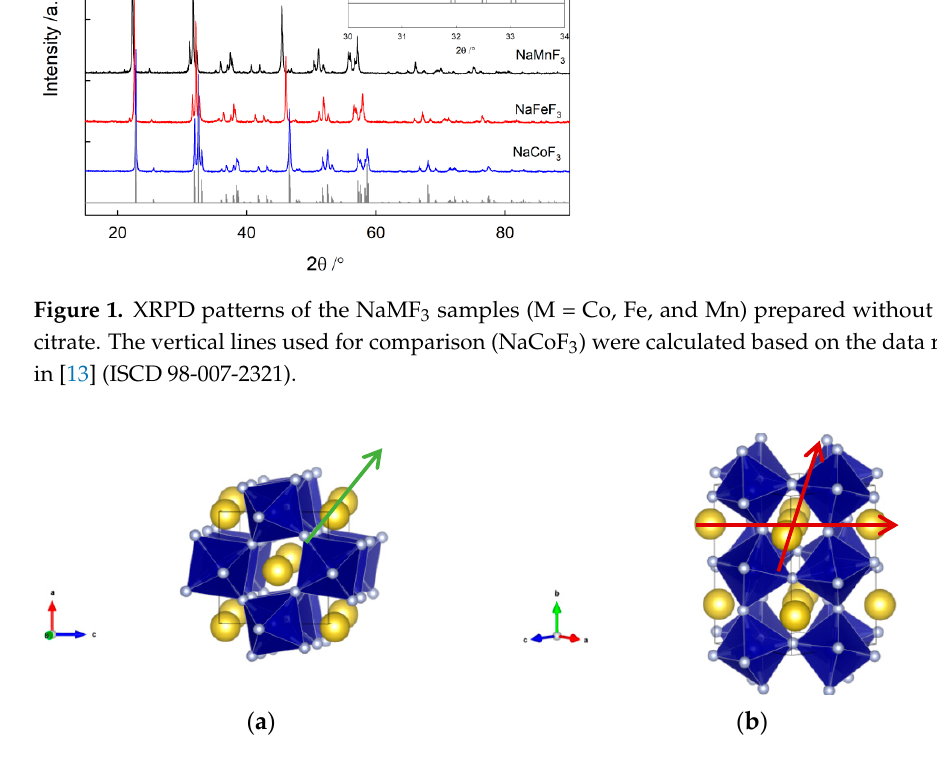
Figure 2. Crystal structures of NaMF 3 , showing the presence of preferential diffusion paths for Na ion diffusion: ( a ) along the crystallographic axis b (green); and ( b ) within the ac plane (red).